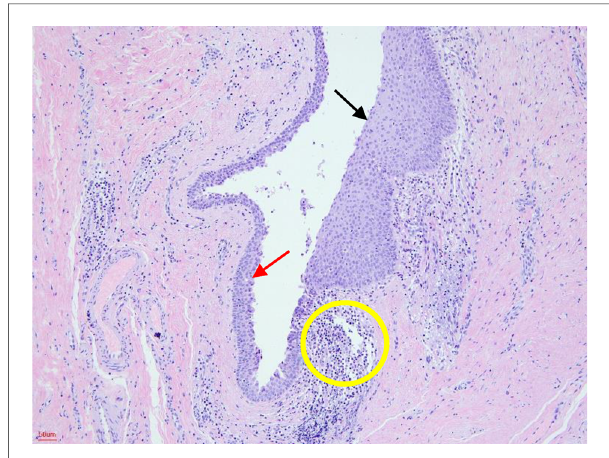
FIGURE 5 Histopathological examination. The cystic wall was lined by strati fi ed squamous epithelium (black arrow) and columnar respiratory epithelium (red arrow). Lymphocyte aggregation can also be seen (yellow circle) (HE, hematoxylin-eosin staining;